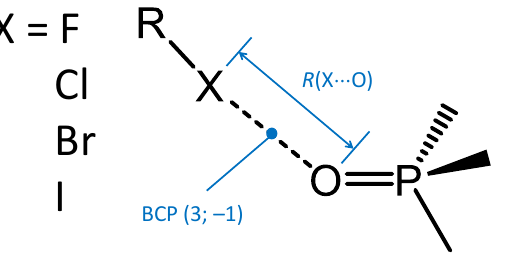
Figure 2. Schematic representation of halogen-bonded complexes formed between R–X (X = F, Cl, Br and I) and Me 3 PO. In blue are given geometric (interatomic distance R (X · · · O)), energetic (complexation enthalpy ∆ H ), and electronic ( ρ stands for electron density, ∇ 2 ρ for its Laplacian, V , G and K stand for local electron potential, kinetic and total energy densities at the bond critical point, BCP) parameters that were correlated with ∆ d in this work (see Figure 1 for the definition of ∆ d ).